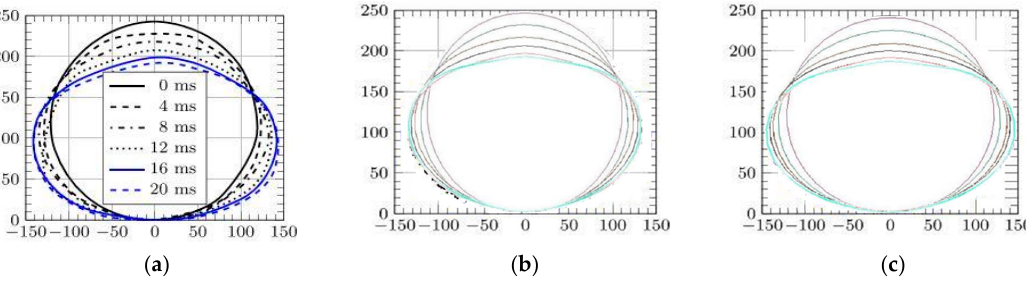
Figure 12. Deformation of the cylinder falling from 1500 mm; ( a ) experiments [42], ( b ) without air, ( c ) with air.